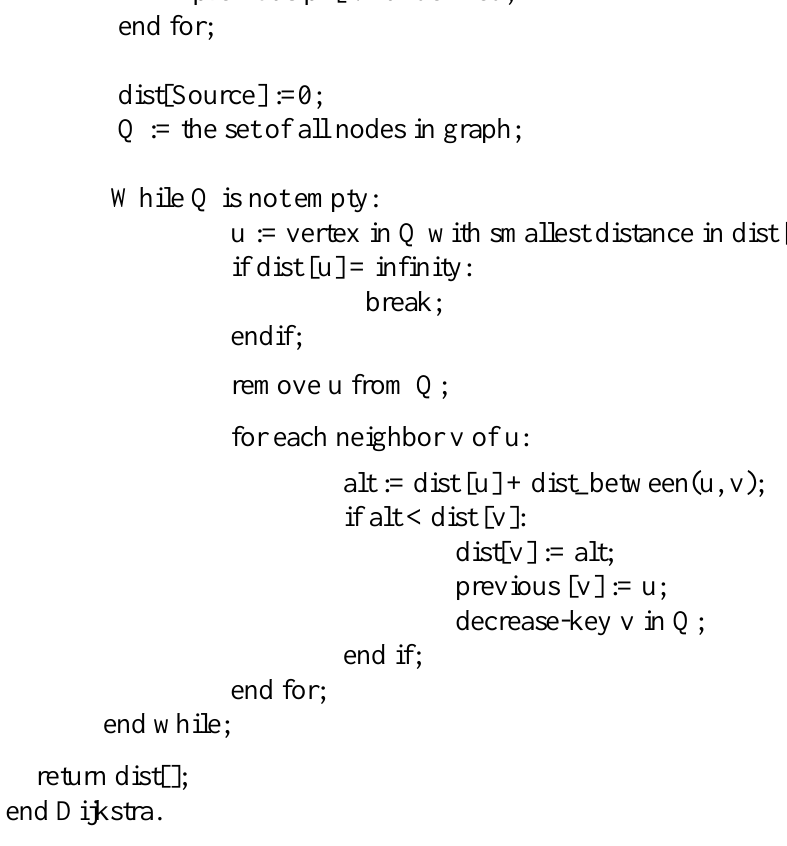
Fig. 2. Dijkstra's algorithm pseudo code (Taken from contributors